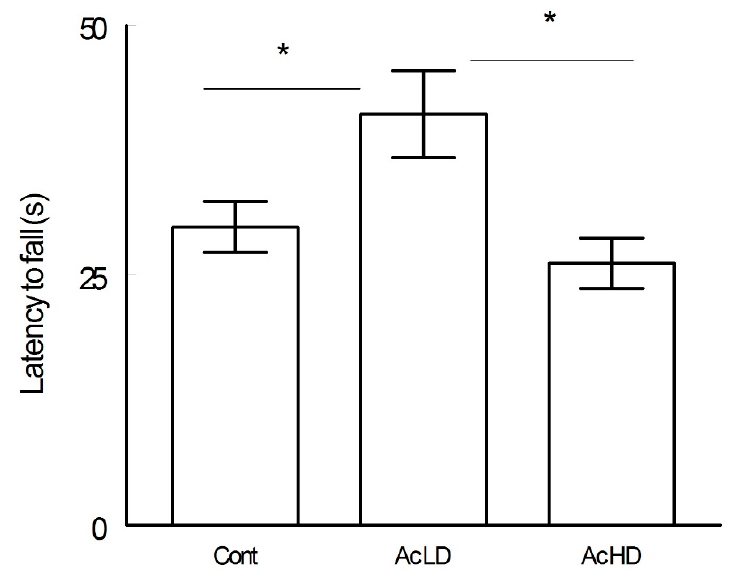
Figure 1. Latency to fall (mean ± SEM seconds) in the rotarod test for the control, moderate dose, and high dose groups. The time spent by Ac MD was significantly more than the other groups (ANOVA test, p < 0.05). Cont: control; Ac MD: moderate dose group; Ac HD: high dose group. Asterisks mark significant differences between the groups.